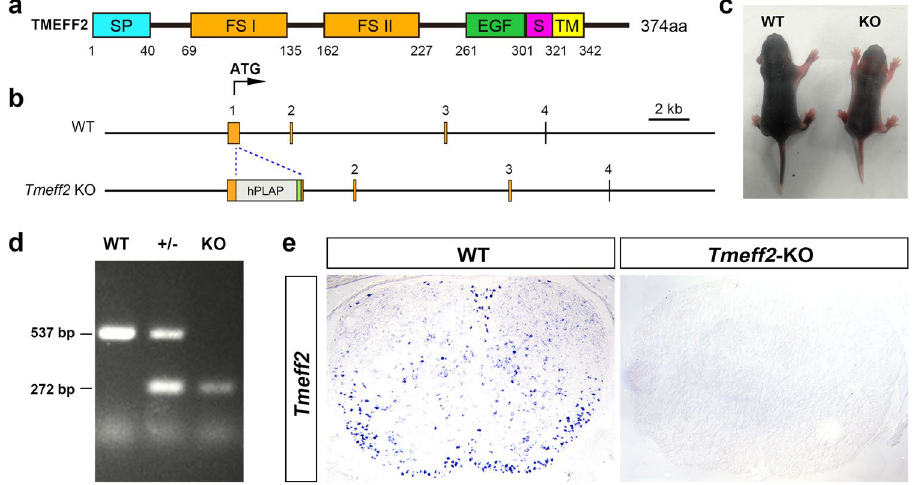
Figure 4. Tmeff2 gene and Tmeff2 -KO mice. ( a ) Structure of TMEFF2. TMEFF2 has a signal peptide (SP), two follistatin-like domains (FS I, FS II), an EGF-like domain (EGF), a shedding domain (S) and a transmembrane domain (TM). ( b ) A schematic of Tmeff2 -KO mice. A human PLAP cassette was inserted after the start codon in the first exon. ( c ) The Tmeff2 -KO mutant mice are smaller than their wild type littermates. ( d ) Genotyping